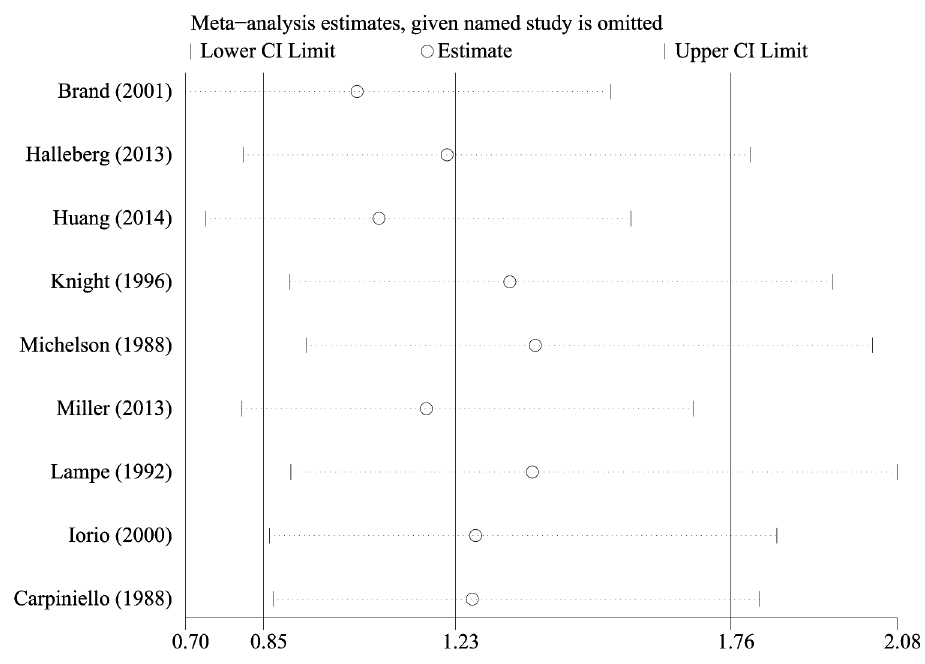
Fig 3. Sensitivity analyses of urinary tract